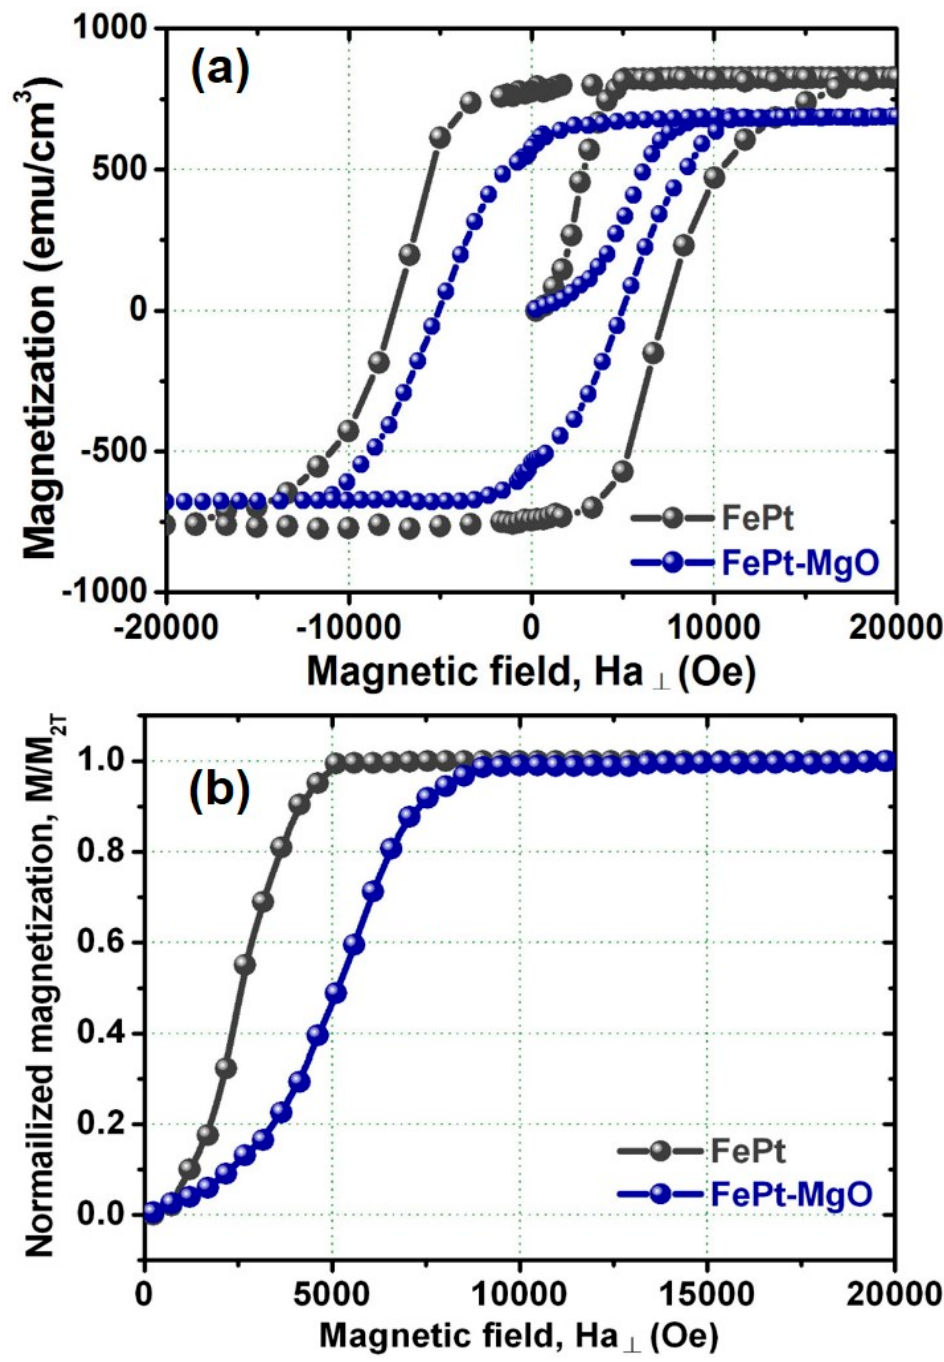
Figure 6. ( a ) Perpendicular magnetization loops and corresponding ( b ) normalized initial magneti- zation loops for the FePt films without and with MgO additive nanolayers. The magnetic field was externally applied in the perpendicular direction to the FePt and FePt–MgO both cases.